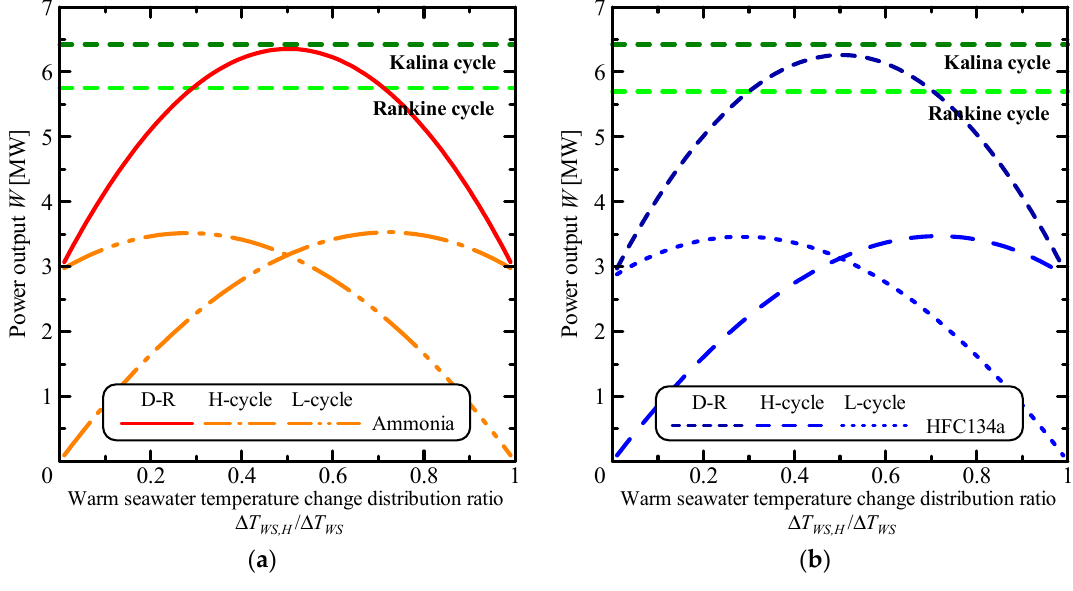
Figure 17. ( a ) Relationship between the power output and the warm seawater temperature change distribution ratio. The working fluid in the single Rankine and double-stage Rankine cycles is ( a ) ammonia and ( b ) HFC134a, respectively.